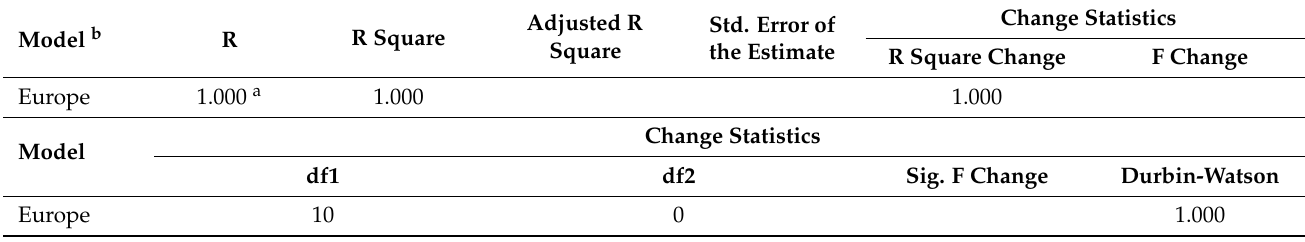
Table 3. Statistical summary of the European regional model.